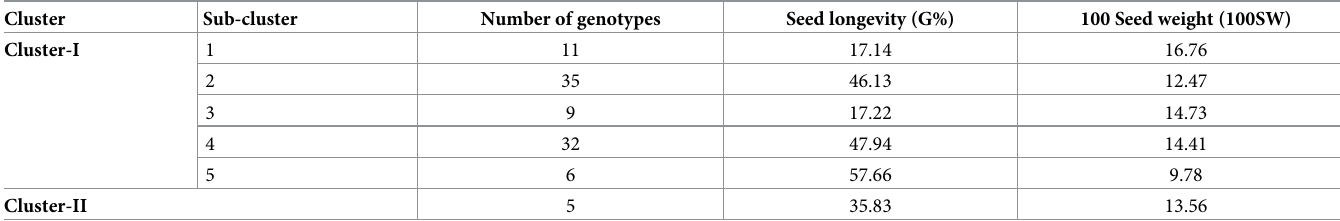
Table 7. Number of genotypes, seed longevity (G%) and 100 seed weight (100SW) of clusters formed in hierarchical clustering using phenotypic